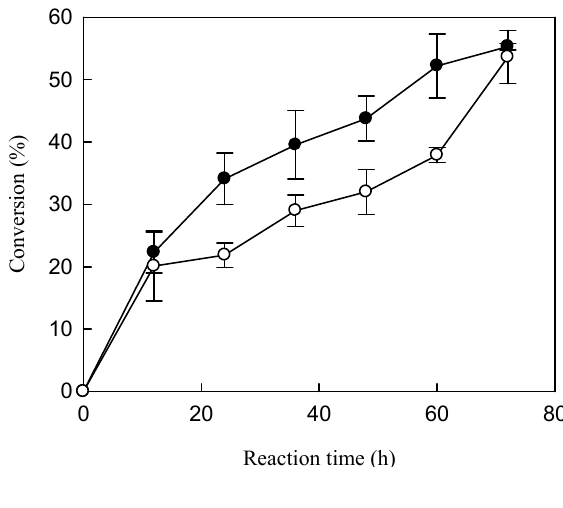
intervals. The reaction was carried out at 40 °C for 72 h with water content of 10% ( w / w of oil). The molar ratio of methanol to oil was 3:1; three separate additions at